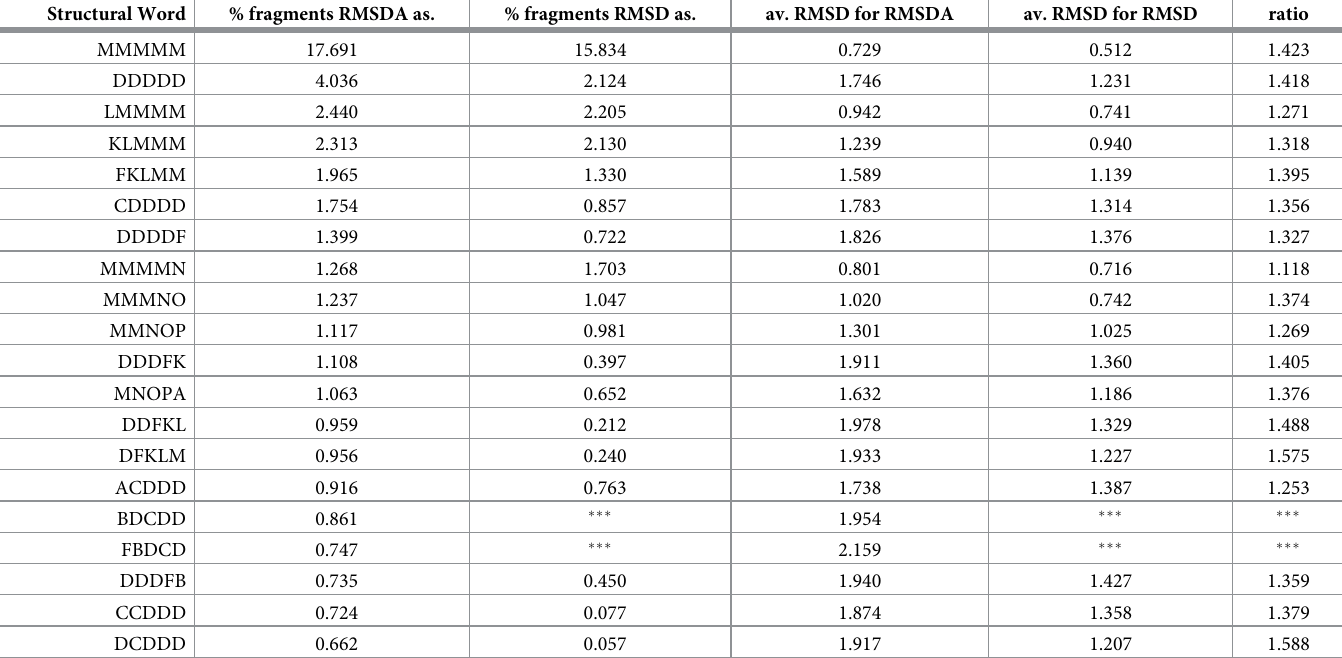
The most common Structural Words for the PISCES30 dataset, obtained through RMSDA- and RMSD-based structural assignments. The SWs are sorted by the topmost common by the RMSDA assignment. The percentage of 9-residue fragments assigned to each SW class is shown in columns two and three: the second column for the RMSDA assignment and the third column for the RMSD. Columns four and five show the average distance between the backbone atoms N , C α , C of the fragments assigned to the same SW, for each assignment respectively; the last column shows the ratio of the distances in columns four and five. The ��� sing stands for the SWs that were not present in the RMSD-based